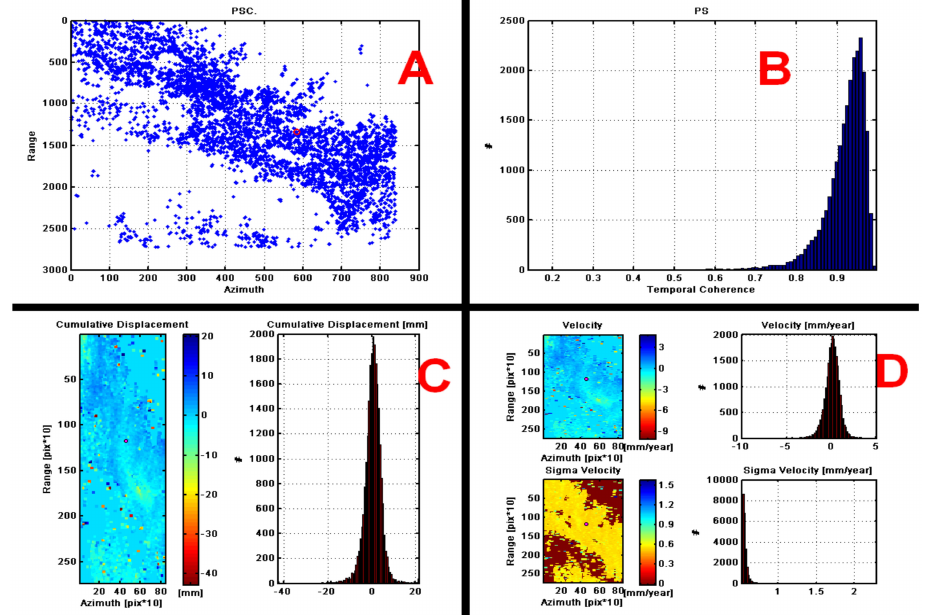
Figure 6. ( A ) 5,277 points for multi-time analisys without atmospheric noise. ( B ) Histogram of scattered points to check the multitemporal analysis of coherence for the estimation of accumulated displacement ( C ) and velocity ( D